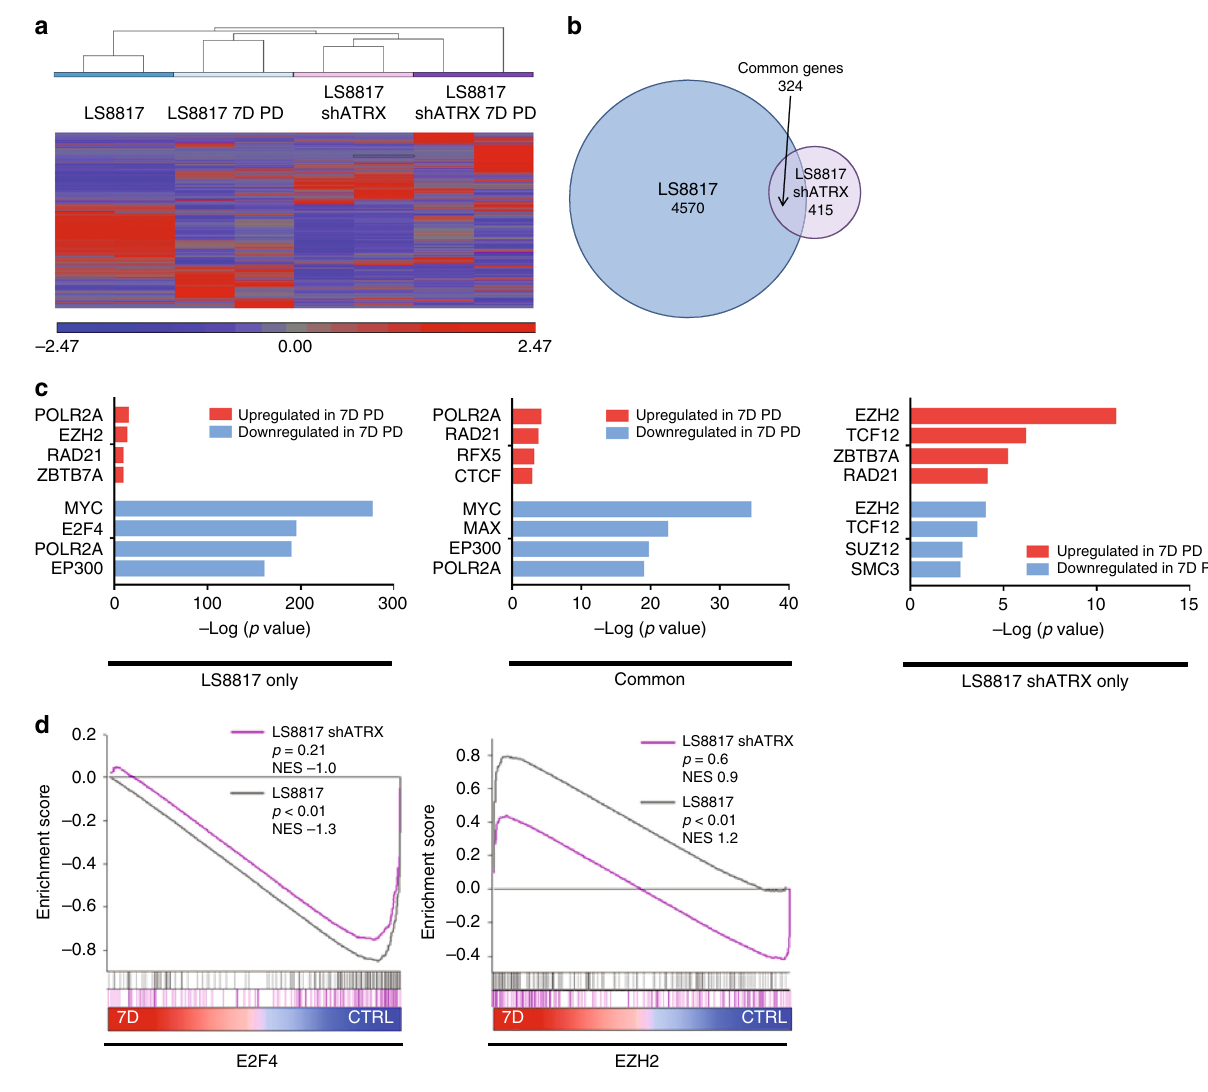
Fig. 5 ATRX affects E2F and EZH2 target gene expression in senescent cells. a Hierarchical clustering based on expression of all RNAs sequenced by RNA-seq. Each row represents a single sample, and the conditions are indicated above; RNA-seq was performed in duplicate on each condition. b Venn Diagram indicating the number of genes that were differentially expressed with a fold change of at least − 1.8 or 1.8 and an FDR < 0.05 across PD-treated vs. control samples in unperturbed and ATRX-de fi cient LS8817 cells; the genes that were found in common across both cell types are indicated. c Enrichr analysis of the top predicted transcription factors that regulate the upregulated and downregulated gene lists from b . The negative log of the p -value for the enrichment scores is plotted. d Gene set enrichment analysis (GSEA) was performed on across PD-treated vs. control samples in unperturbed and ATRX- de fi cient LS8817 cells, speci fi cally analyzing E2F4 and EZH2 gene signatures. The pro fi les are shown with their corresponding normalized enrichment score (NES) and FWER p